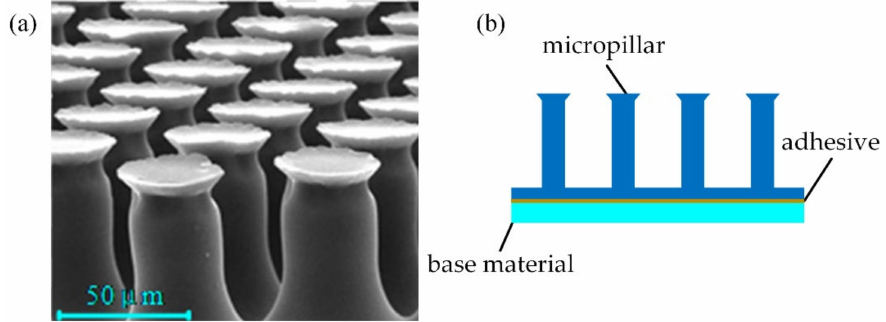
Figure 2. PVS material micro-structure and adhesion material composition: ( a ) The dry adhesion material’s micro-structure; ( b ) the composition of adhesion